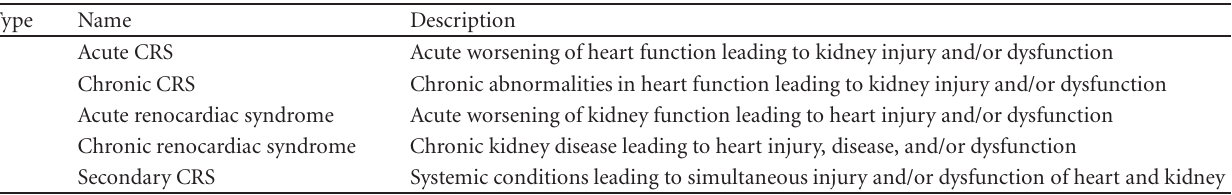
Table 1: Classification scheme of the di ff erent types of the cardiorenal